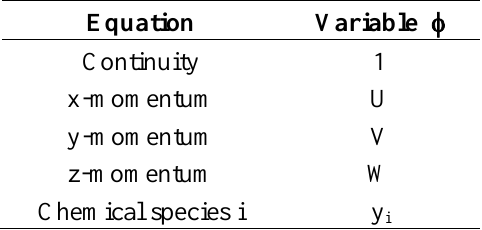
Table 1. Transport equations used in the CFD